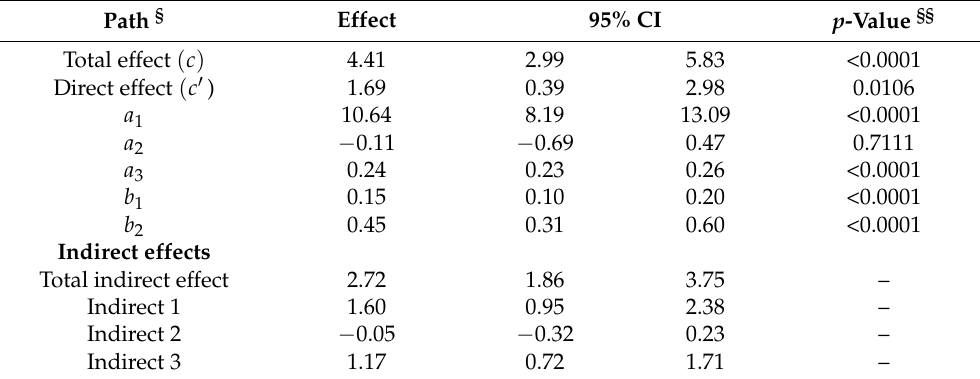
Figure 3. Statistical estimations of serial multiple mediation analyses. Each arrow shows the esti- mated coefficient. * p -value < 0.05. coefficient. * p -value < 0.05. Table 3. The serial mediation of interpersonal and individual stigma between the familiarity with transgender sports bans and suicidal